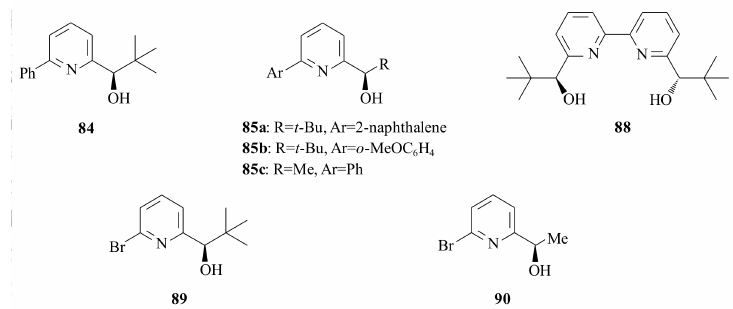
Figure 16. Pyridinyl alcoholato ligands used for asymmetric additions to